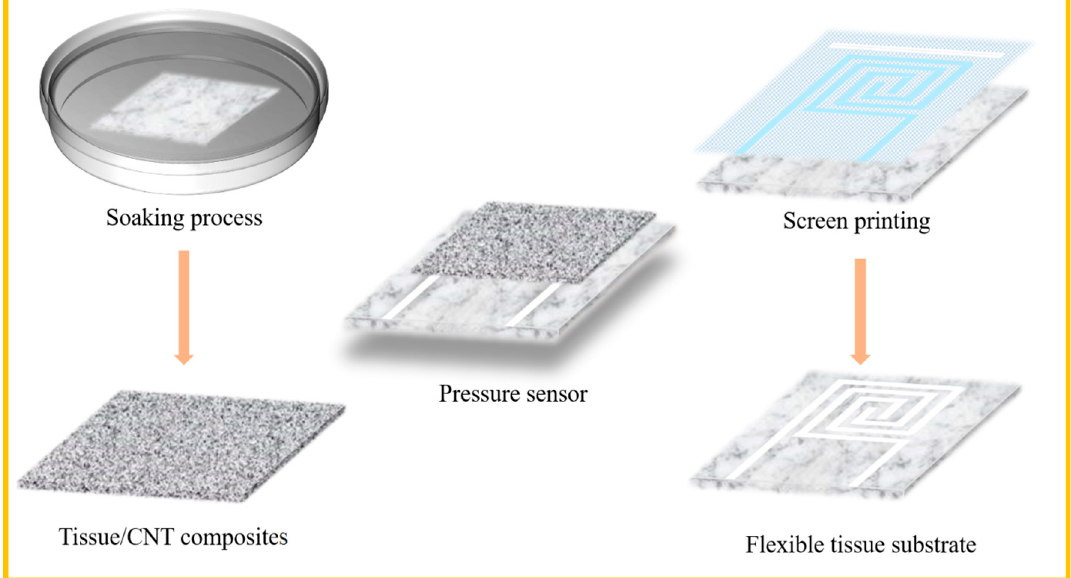
Figure 1. Schematic illustration of the fabrication procedure of all-tissue-based pressure sensors.